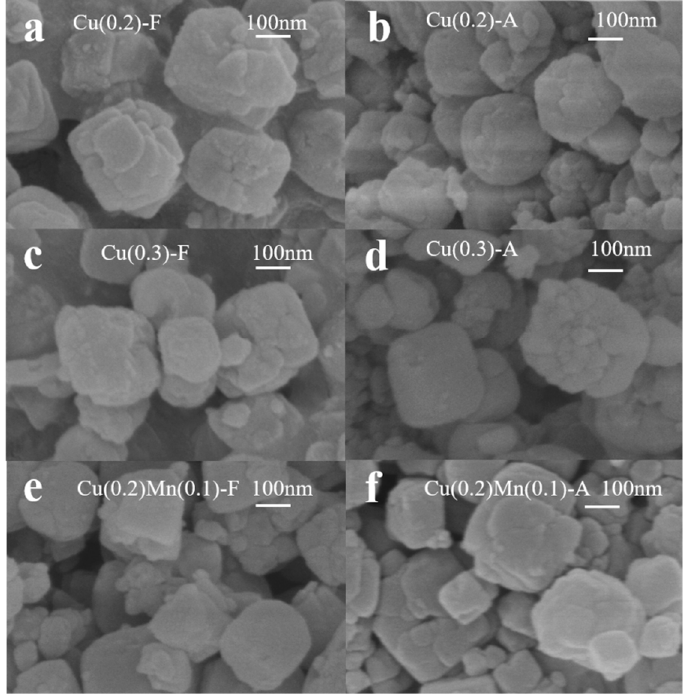
Figure 8. SEM images of catalysts before ( a , c , e ) and after ( b , d , f ) hydrothermal aging.